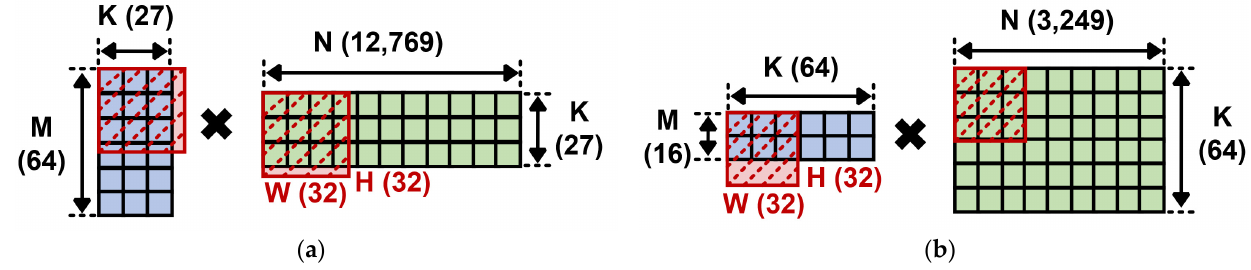
Figure 4. Matrix multiplication with 32 × 32 PE array Gemmini: ( a ) Case of 3 × 3, and ( b ) 1 × 1 convolution layers in SqueezeNet. Table 2. Acceleration utilization of SqueezeNet v1.1 on NPUs.